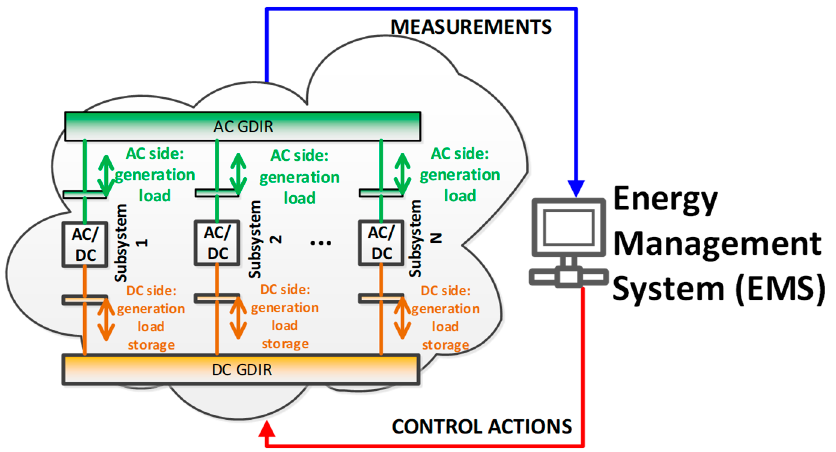
Figure 1. A Hybrid AC/DC System.